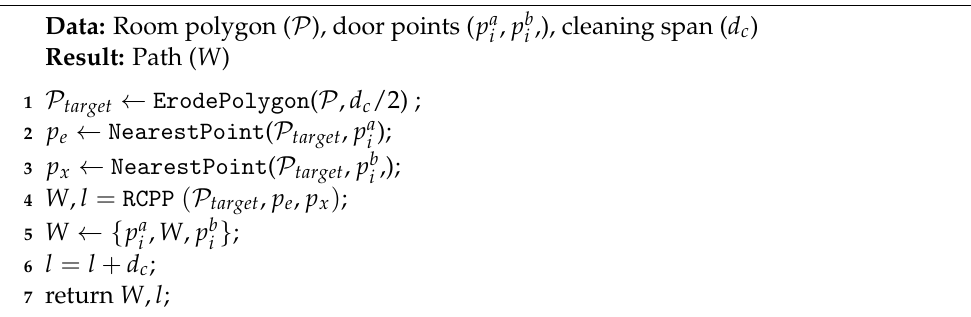
, p b , d c ) . Coverage path planning for a single i i